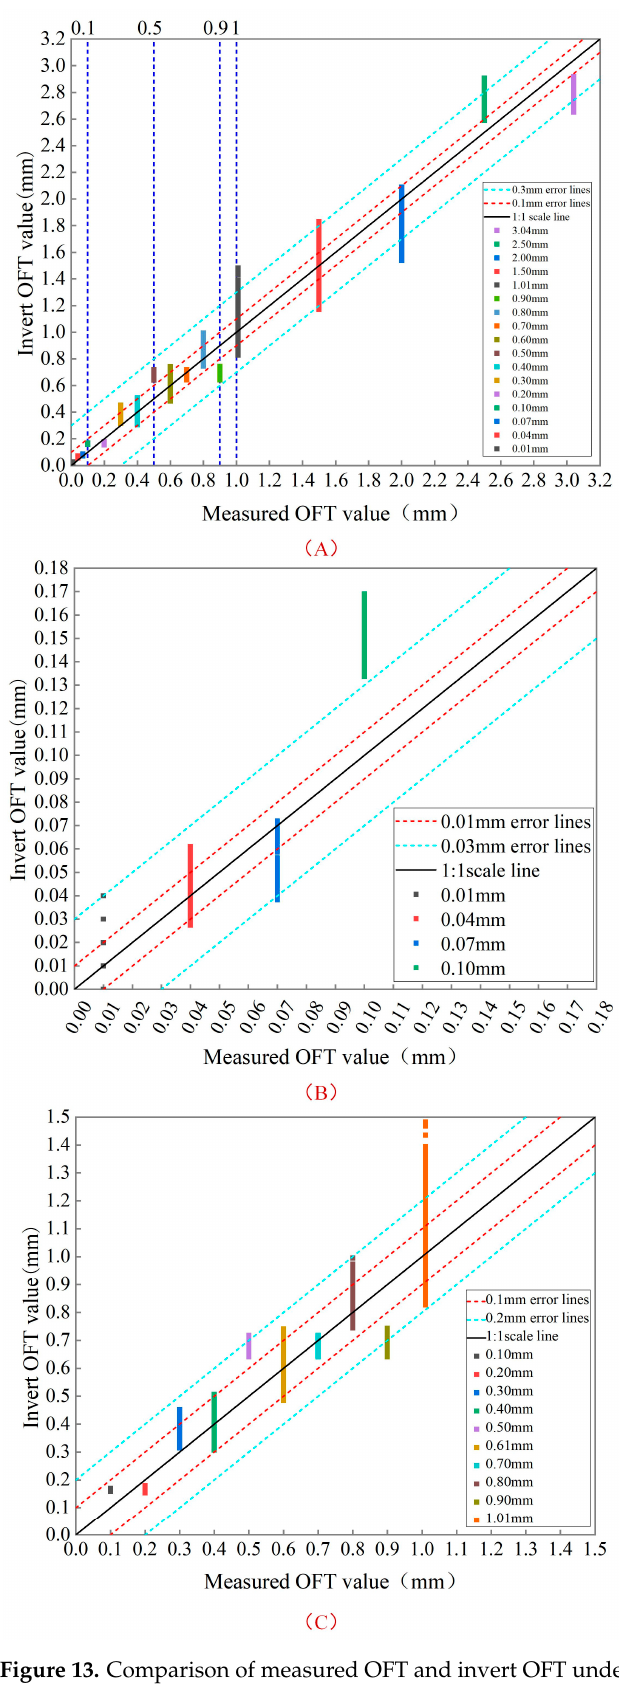
Figure 13. Comparison of measured OFT and invert OFT under autumn dataset: ( A ) 0.01–3.00 mm;